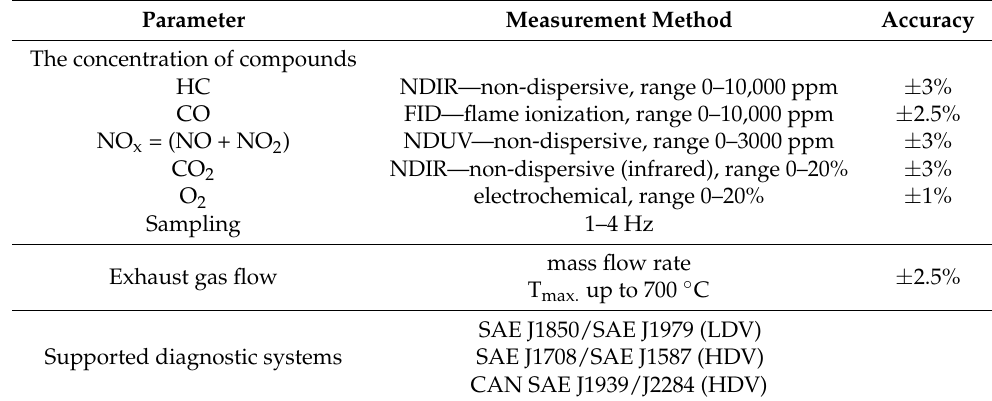
Table 1. Technical data of the Semtech DS.